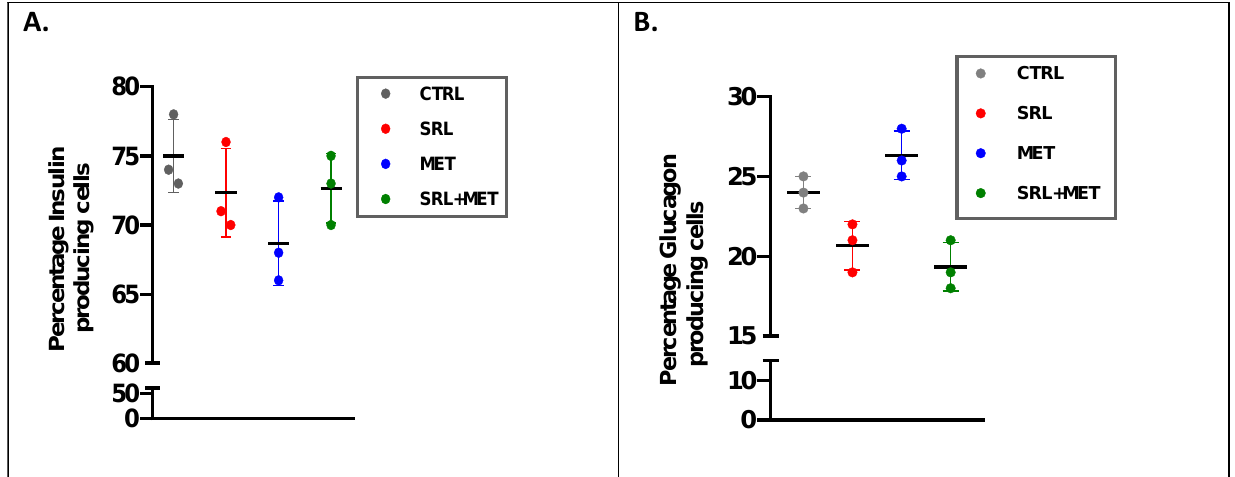
Figure 5. The percentage distribution of ( A ) insulin and ( B ) glucagon-positive cells in mice pancreatic islets of different treatment groups (CTRL, SRL, MET, and SRL+MET). There was no significant difference was noted in the pattern of distribution of insulin and glucagon-positive cells in any of the studied groups( n = 3).